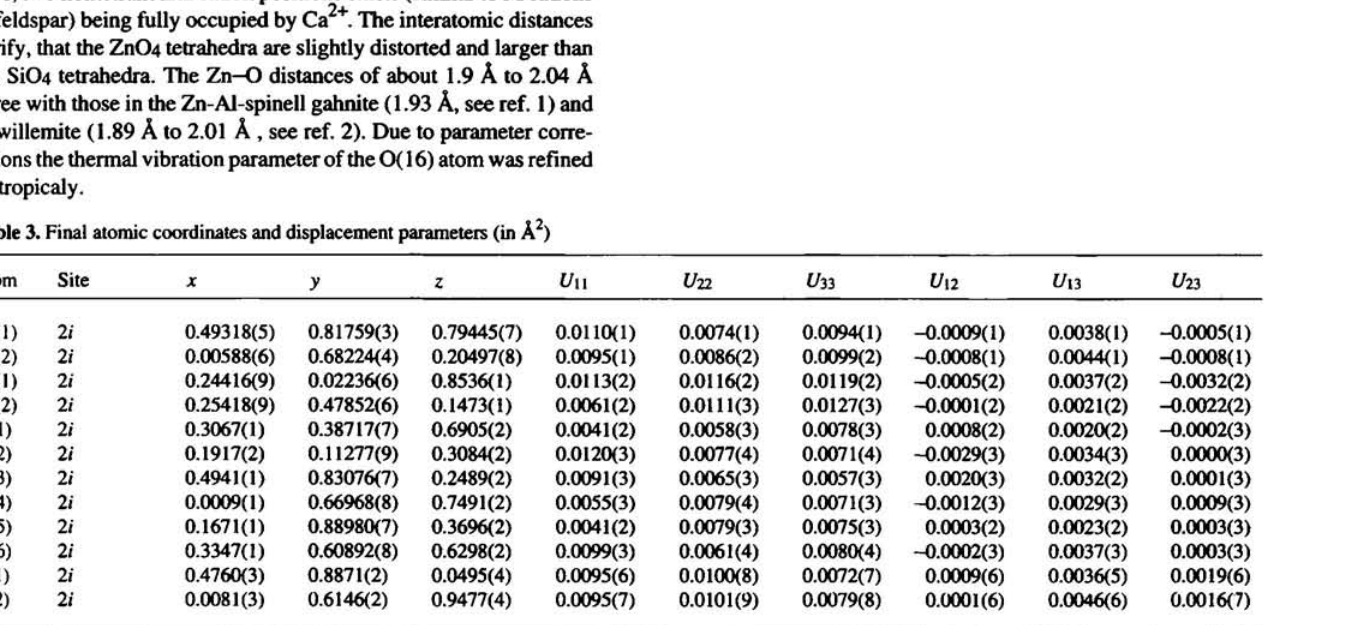
Table 3. Final atomic coordinates and displacement parameters (in Â^)